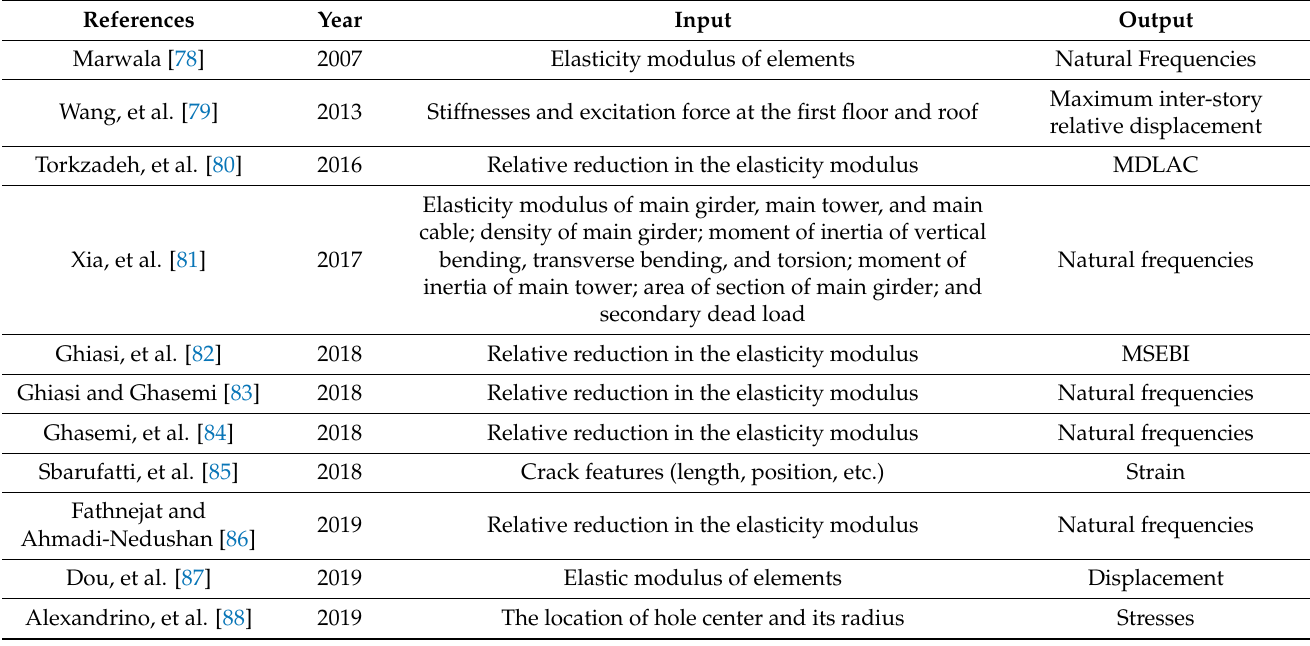
Figure 11. The procedure of applying parametric emulators for damage identification. Table 2. The inputs and outputs of parametric